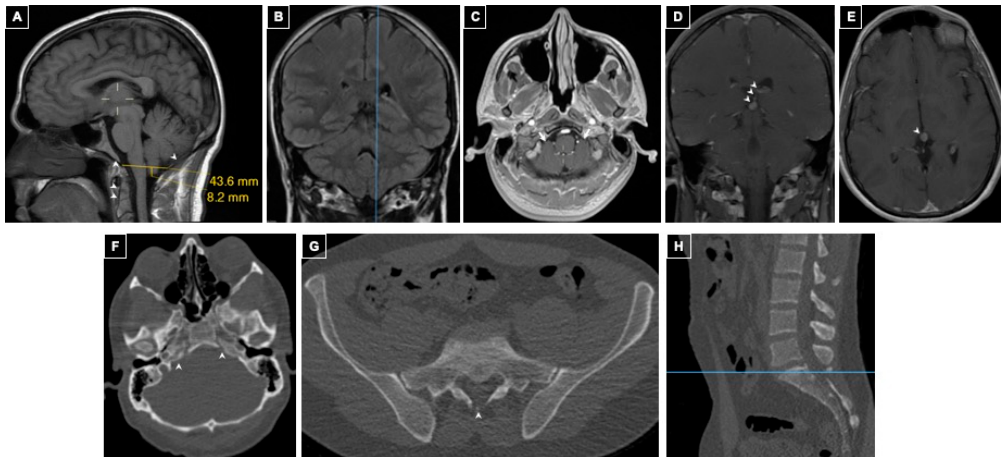
Figure 2. Patient 2 Intracranial and Spinal Imaging. Panels ( A – E ) : MRI of the brain. Panel ( A ): Sagittal post-contrast T1-weighted sequence shows the left cerebellar tonsil at the lowest tonsillar position, 8 mm through the foramen magnum. Narrow, underdeveloped clivus and occipital bone as well as uncalcified synchondroses of the odontoid are also seen (arrowheads). Panel ( B ): Coronal T1-weighted sequence demonstrating the location of the measurement in A. Panel ( C ): Axial post-contrast T1-weighted sequence showing crowding of the brainstem by the cerebellar tonsils in the foramen magnum (arrows). Panel ( D ): Coronal T1-weighted venous phase post-contrast sequence shows a developmental venous anomaly of the Vein of Galen confluens draining the choroid plexus through the velum interpositum (arrowheads). Panel ( E ): Axial T1-weighted venous phase post-contrast sequence showing the anomalous Vein of Galen confluens. Panel ( F ): Axial CT of the head showing petroclival dysraphism or uncalcified petroclival synchondrosis (arrowheads). Panel ( G ): Axial CT of lumbo-sacral spine shows occult dysraphism of S1 (arrowhead) and sacral segmentation anomalies (arrows). Panel ( H ): Sagittal lumbar CT demonstrating the level of the image shown in G.